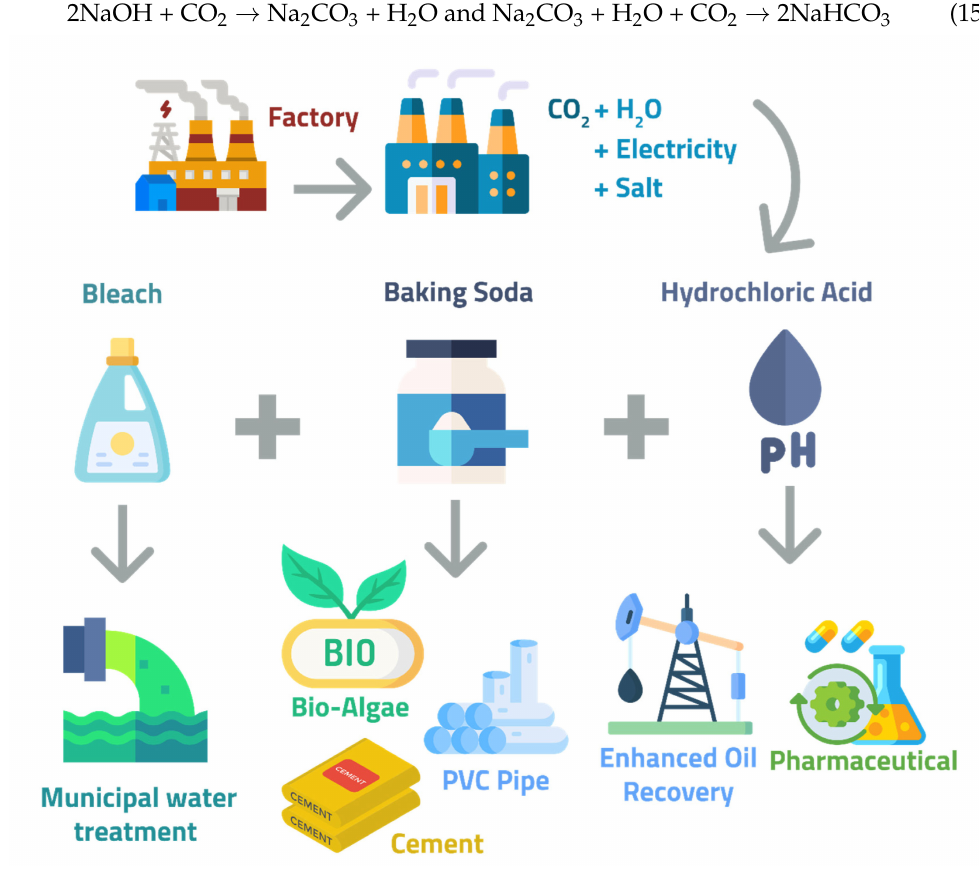
Figure 9. Schematic Diagram for SkyMine Process [83–85]. Potential applications of Products from the Skyonic and Calera process are highlighted in Table